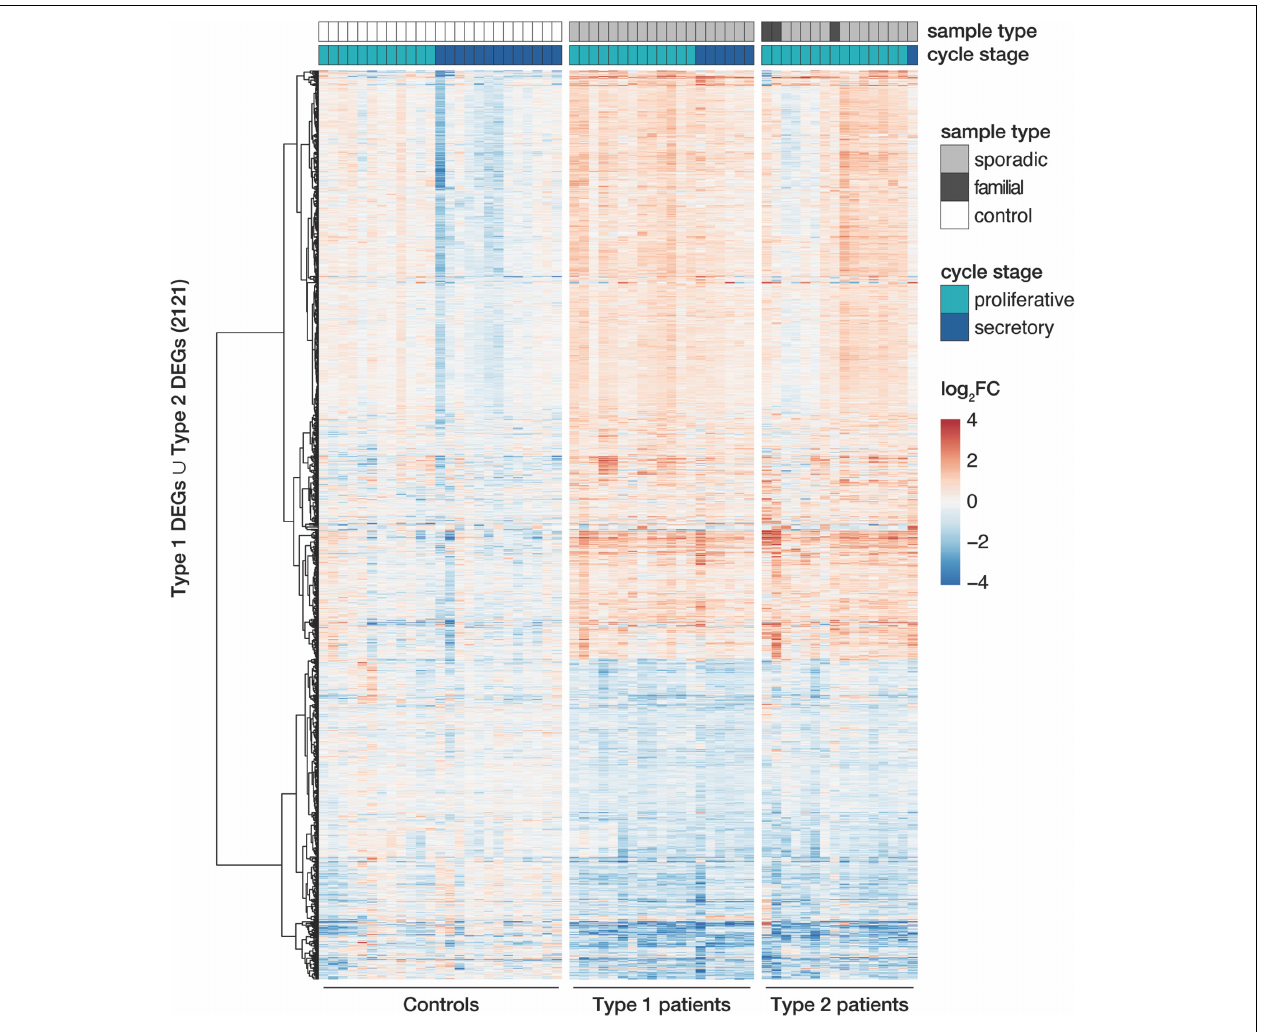
FIGURE 2 | MRKH types 1 and 2 patients show largely similar perturbation patterns in endometrial gene expression. Expression profiles (log 2 expression change relative to Ctrl group) of 2121 DEGs (union of DEGs indicated in Figure 1B ) across all samples. Rows hierarchically clustered by Euclidian distance and ward.D2 method. Cycle information (proliferative or secretory) and patient type (sporadic, familial, or control) on top. For details see Supplementary Table S1